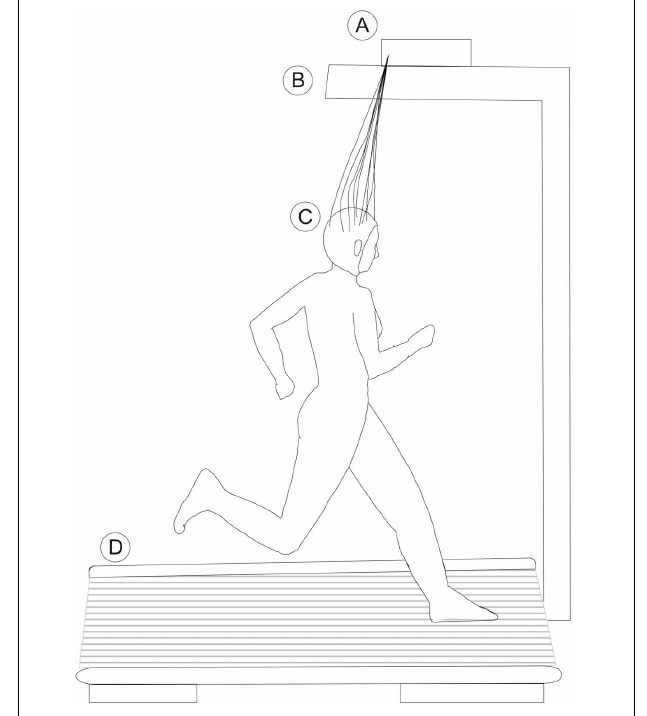
FIGURE 4 | Schematic of an over head holder for EEG amplifiers. A, Amplifier; B, Arm holding the amplifier; C, Subject running on a treadmill